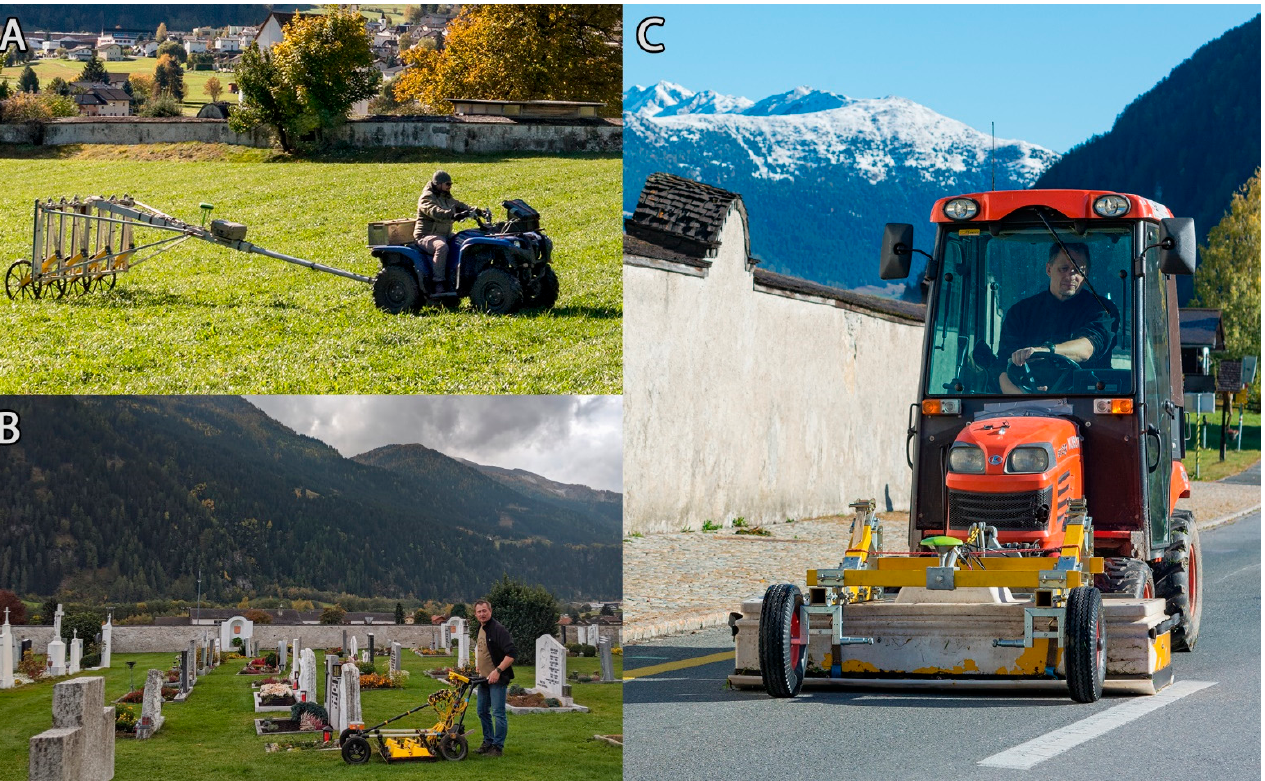
Figure 4. The three geophysical prospection systems applied in Müstair: ( A ) motorised multisensory fluxgate magnetometer, ( B ) handheld three-antenna GPR, and ( C ) motorised 16-channel GPR. Photograph ( A ) by Klaus Löcker, ( B ) by Jona Schlegel, and ( C ) by Geert J. Verhoeven.